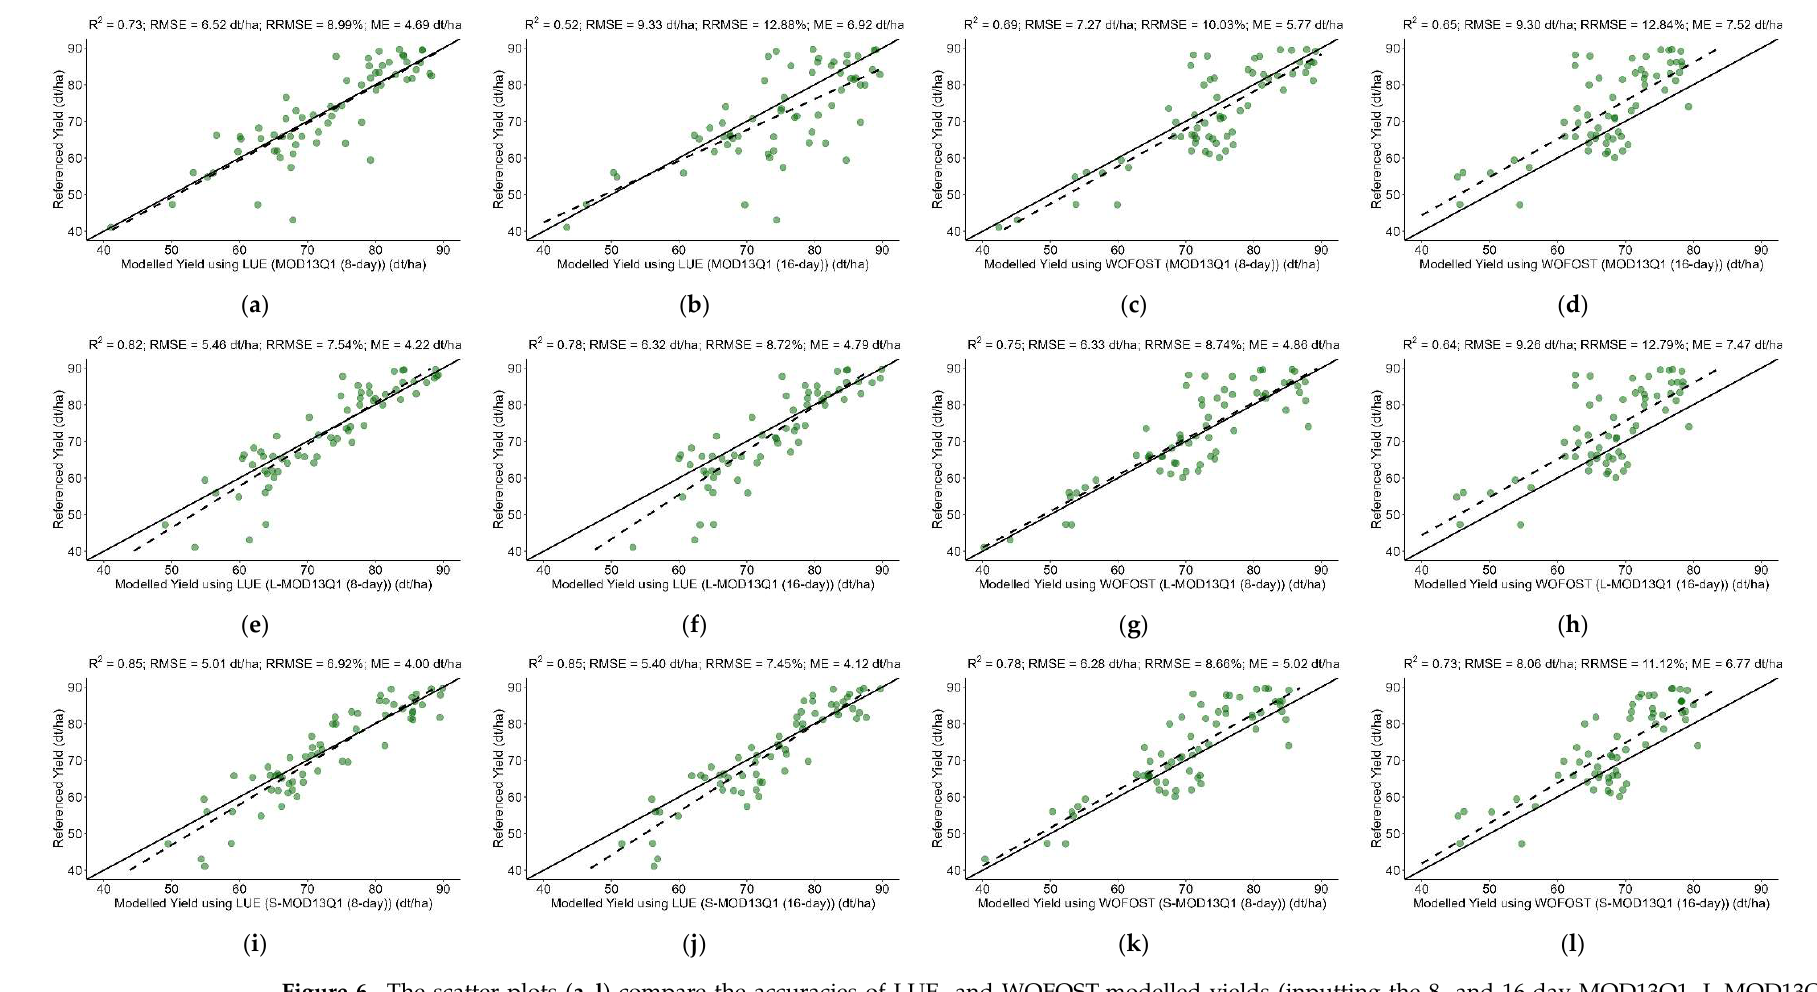
Figure 6. The scatter plots ( a – l ) compare the accuracies of LUE- and WOFOST-modelled yields (inputting the 8- and 16-day MOD13Q1, L-MOD13Q1 and S-MOD13Q1) with the referenced yield of WW. The green dots represent WW. Every plot contains a solid line to visualise the correlation of pixels between the referenced and modelled yield values.